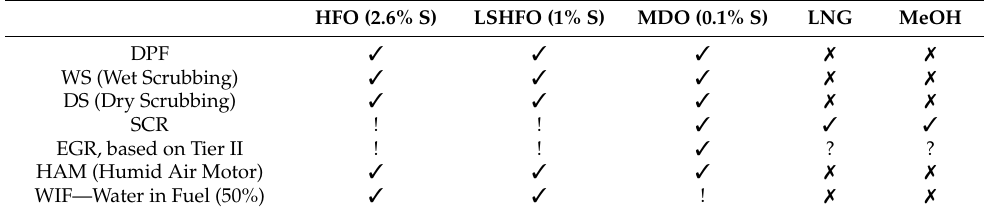
Table 4. Emissions abatement technologies integration when different fuels are